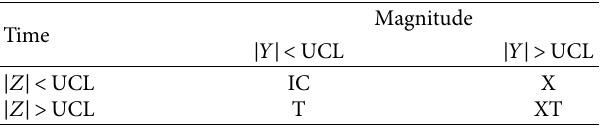
Table 2: Symbols representing the source of the out-of-control